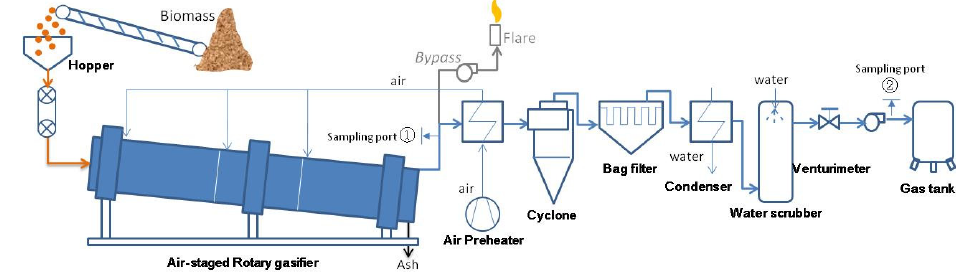
Figure 2. Flow diagram of the gasification plant.